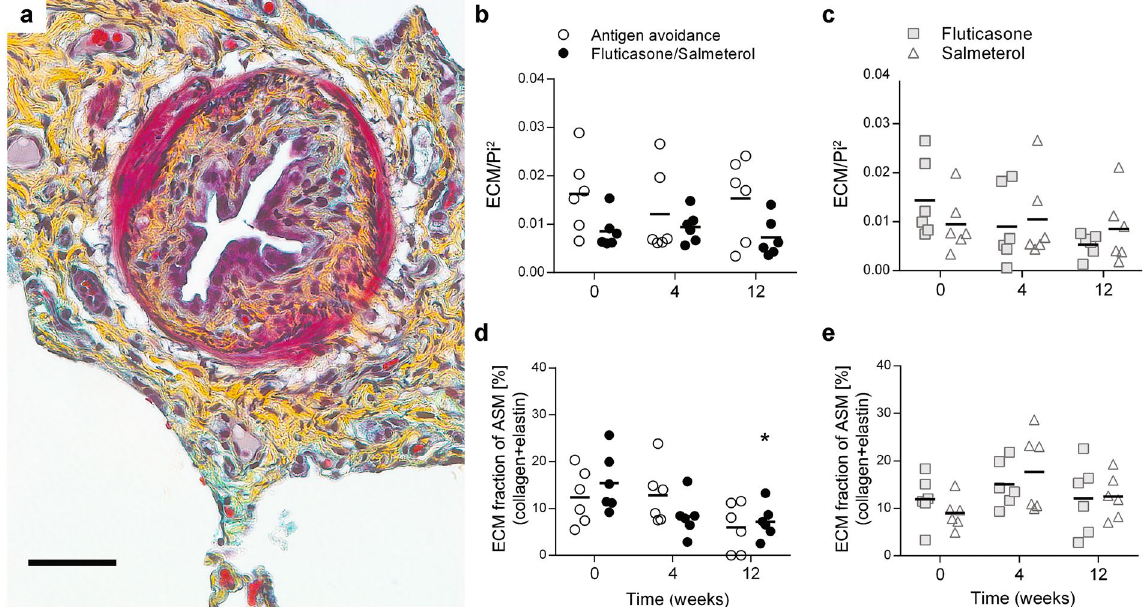
Figure 4. Peripheral ECM remodelling. ( a ) Representative image of a small airway of an asthmatic horse in which smooth muscle stains dark pink, collagen stains yellow, and elastin stains black (Russell-Movat pentachrome staining). Scale bar: 50 μ m. ( b,c ) Corrected area of total ECM within the lamina propria of small airways of the horses participating in study I ( b ) and II ( b ). Each symbol represents one horse (mean value of multiple measures performed). ( d-e ) ECM fraction within the peripheral ASM layer of horses participating in study I ( d ) and II ( e ). * Different from baseline of the same group (p < 0.05). ECM: extracellular matrix; EF: elastic fibers; Pi: internal